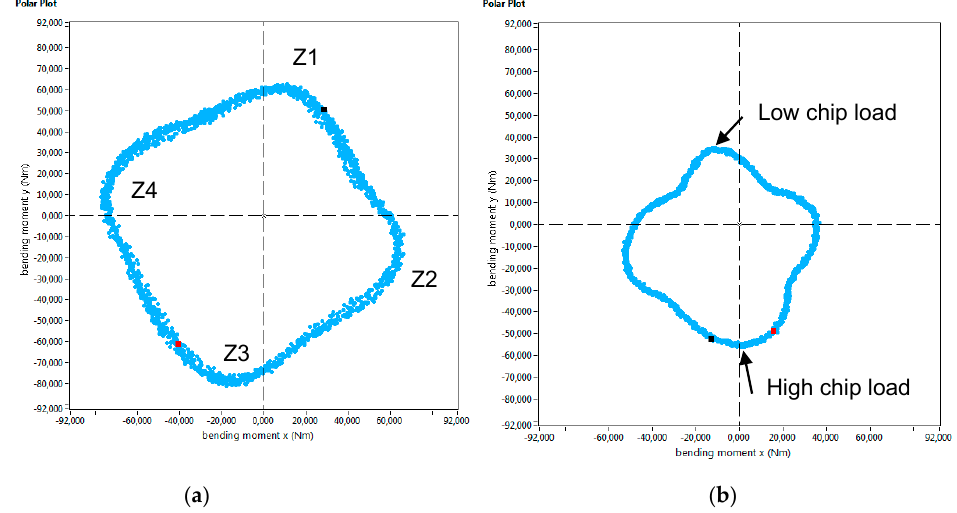
Figure 14. Polar plot of the average bending moment in the first set of experiments (second pass).